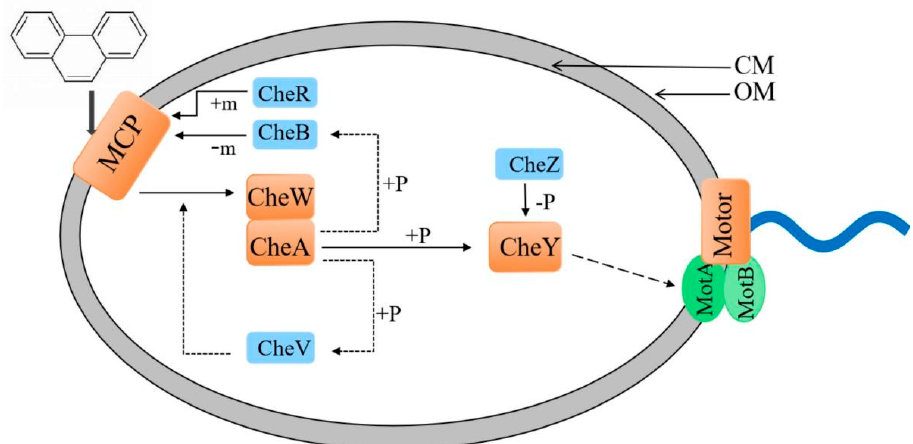
Figure 4. Chemotaxis and motility of Variovorax sp. strain N23. The chemotaxis and motility genes are predicted by the KEGG database. +m—methylation; − m—demethylation; +P—phosphorylation; − P—dephosphorylation; OM—outer membrane; CM—cytoplasm (inner membrane). The solid and long dotted arrows represent one-step and multistep reactions, respectively. The short, dotted arrows represent feedback regulation.